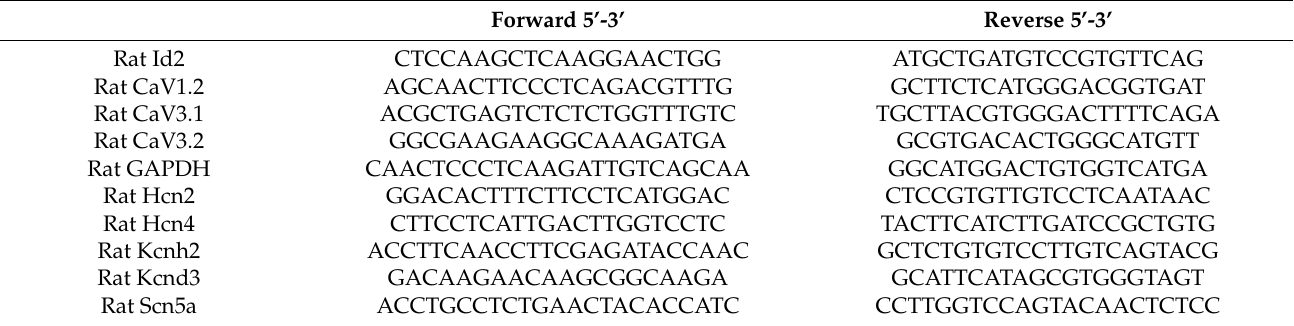
Table 4. Primer sequences used for RT or real-time